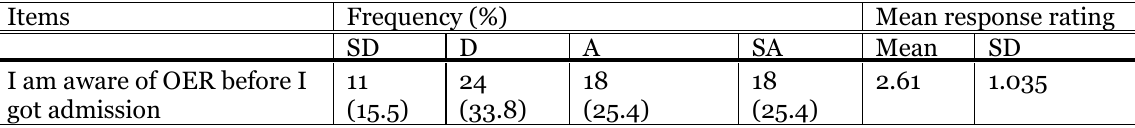
Observation Recorded on the Use of